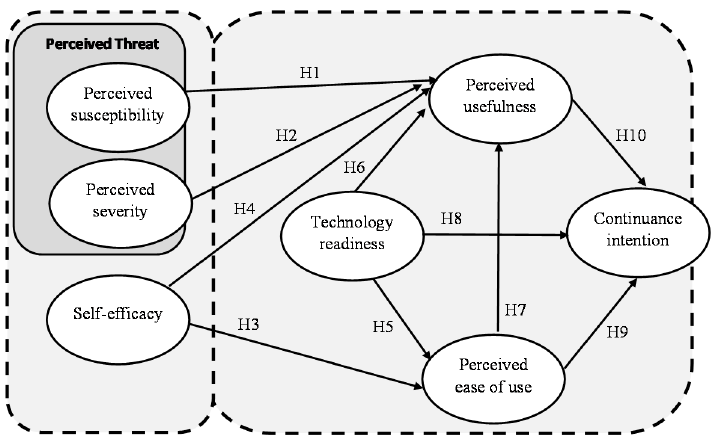
Figure 1. Conceptual model and